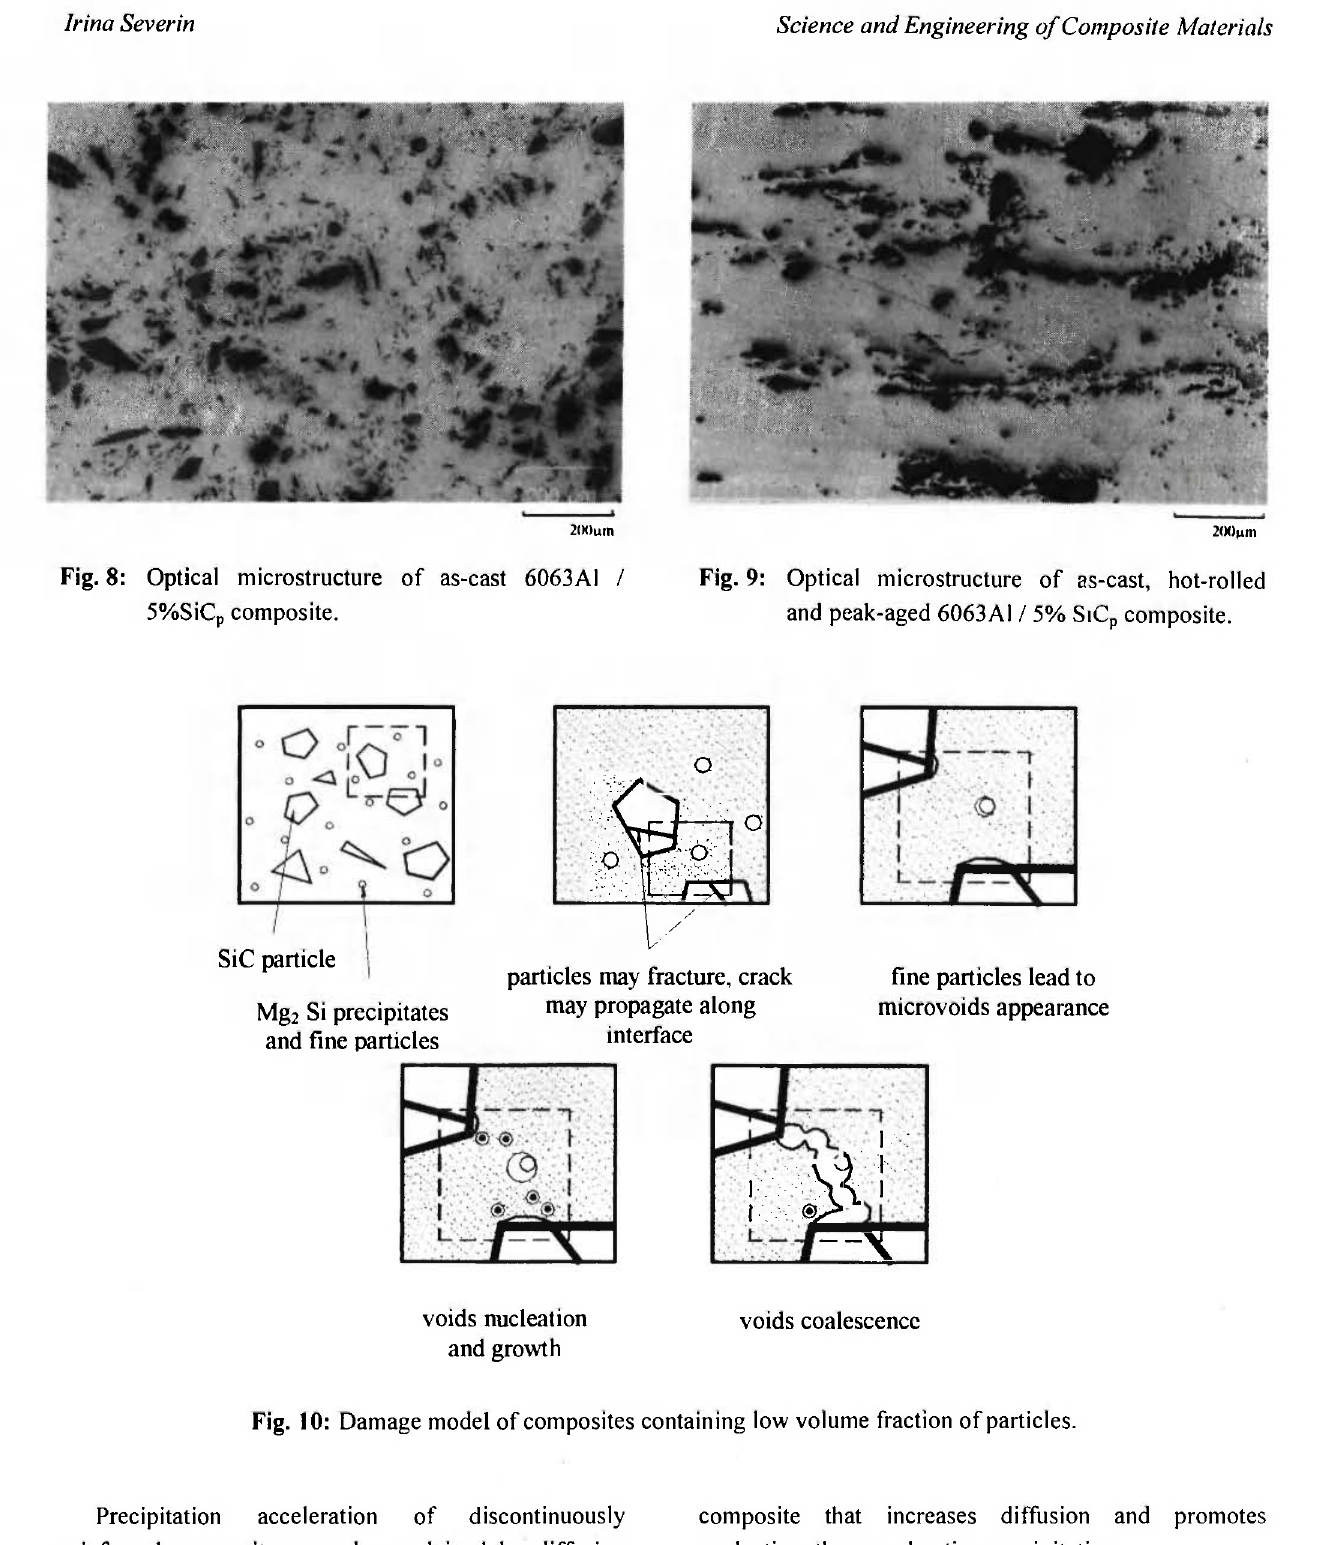
Fig. 10: Damage model of composites containing low volume fraction of